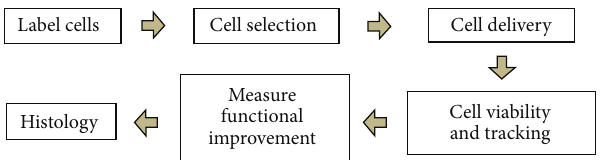
Figure 1: Procedure for SCT. Cells can be labeled with contrast agent either directly or indirectly. The labeled cells are purified from unlabeled cells to obtain a cell product with high signal and thus contrast versus adjacent tissue. Before the delivery, the stability of the labeled cells can be tested to assess any potential toxicity of the imaging agent. After delivery, the viability of the delivered cells is monitored to understand engraftment and survival. The labeled stem cells can be clearly recognized due to increased signal produced by the label. Finally, histology and associated microscopy techniques can confirm that the imaging signal does indeed correspond to the cells of interest.